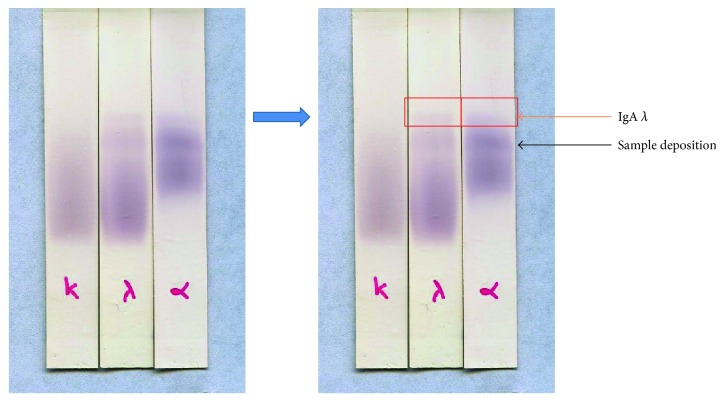
Immunoblot of the serum protein electrophoresis (sPEP) in the reported case. The red square indicates the identification of a low-level monoclonal protein IgA-λ using immunoblot of the sPEP. Its presence went unperceived in routine sPEP due to its very limited quantity masked by the dominant presence of beta-2-globulins. Fixation was performed at a 1/50 serum dilution. The labels below each track indicate the antibody used to reveal the Ig (from left to right): κ—light chain kappa, λ—light chain lambda, and α—heavy chain alpha (IgA).